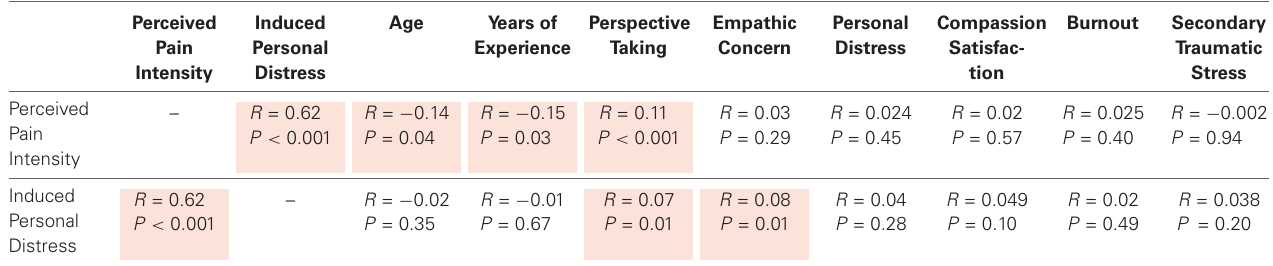
Table 3 | Summary of correlations found between subjective ratings of pain intensity and induced personal distress and individual dispositions for the different facets of empathy and other variables . Perceived